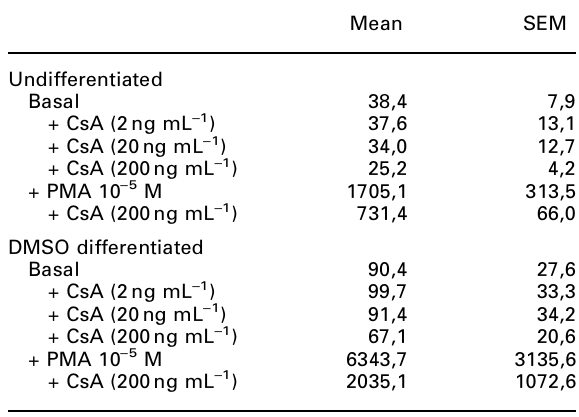
Table 1. Effect of CsA on basal and stimulated IL-6 secretion by U937 cells (pg/10 6 cells). Both in undifferentiated and differentiated U937 cells, at the highest concentration used (200 ng/mL) CsA decreased stimulated secretion of IL-6.